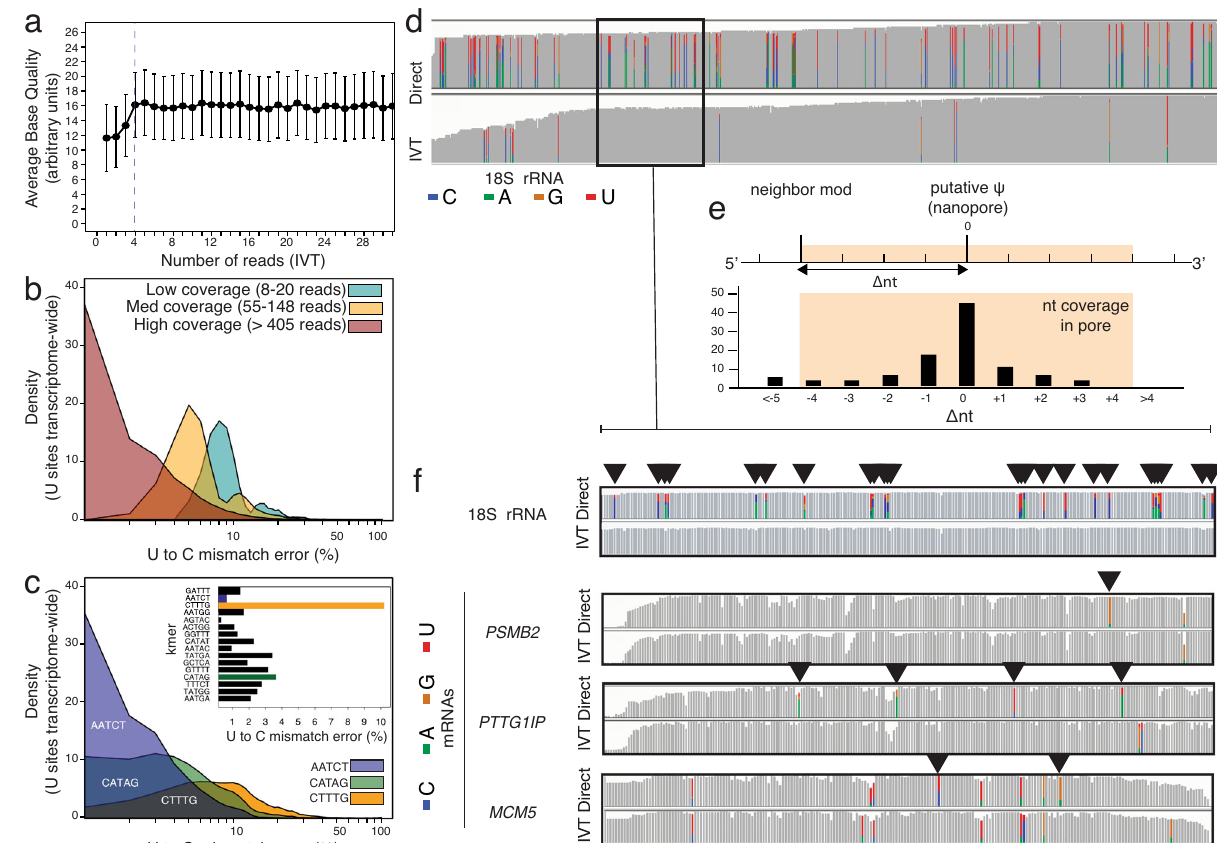
Fig. 2 | Basecalling errors can be used to detect RNA modi fi cations if speci fi c k-mer and coverage are considered, and the density of satellite modi fi cations on rRNAs is different from mRNAs. a Average base quality for different numbers of reads using IVT reads. Data are represented as mean±standard deviation. b Distribution of U-to-Cmismatchpercentagefor three populations basedon read coverage (low coverage, teal; medium coverage, yellow; high coverage, red). c DistributionofU-to-Cmismatchpercentageforthreepopulationsbasedon5-mer sequences (AATCT, blue; CATAG, green; CTTTG, yellow). d IGV snapshot of 18S rRNAforDirect(Upper)andIVT(lower).Correctlyalignedbasesareshowningray,